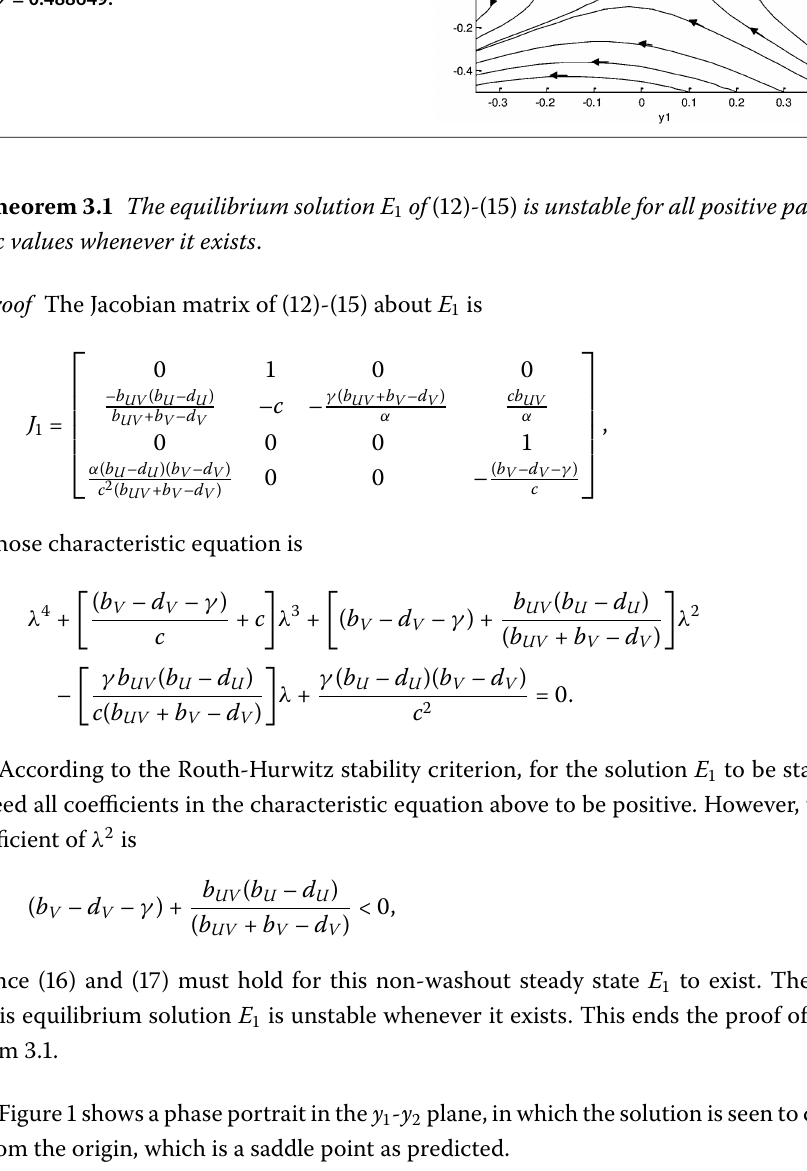
Figure 1 Phase portrait of the system (12)-(15) with b S – d S = –1.017520494, b I – d I = 0.040524417, b SI = 0.2, α = 0.437838, β = 0.032432, c = 0.402694, μ = 0.120808 and γ =